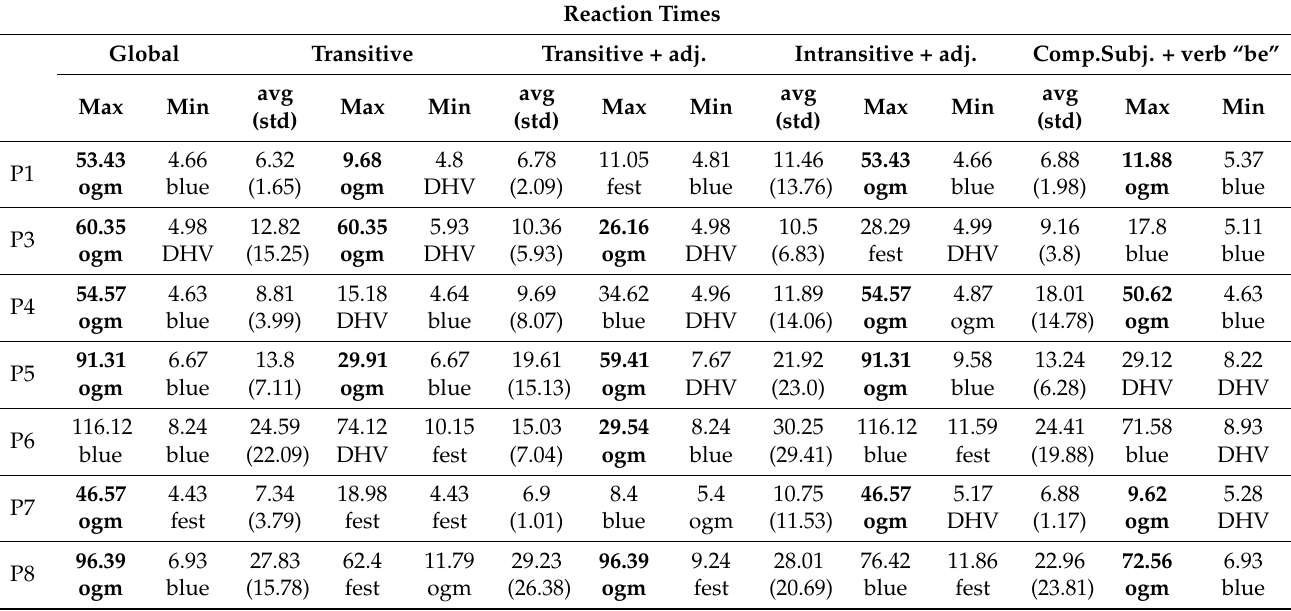
Table 1. The maximum and minimum RTs are detailed together with the system name. The analysis of the reaction times was done using a generalised estimating equation method [26]. The reason for using this model was because the data were not normally distributed, and they represented a repeated measurement. We highlighted Ogmios synthesis sentences that had the worst RTs to emphasise that they were the majority compared with the rest of the TTS systems and the DHV. Moreover, we corroborate in Table 2 that the longest RTs for most of the patients occurred with the Ogmios synthesis samples. In general, Bluemix and DHV achieved closer to average RTs, although Festival TTS took the lead in a couple of patients. Surprisingly, Patient 6 had longer RTs for the DHV and Bluemix. Table 1. Patients’ reaction times overview for types of sentences: “DHV” (digitised human voice), “ogm” (Ogmios), “blue” (Bluemix) and “fest” (Festival TTS). The highest values for Ogmios are highlighted in bold to show that, in the majority of cases, this was the TTS system causing consistently longer RTs. RTs are reported in seconds. Reaction Times Transitive Transitive + adj. Intransitive + adj.